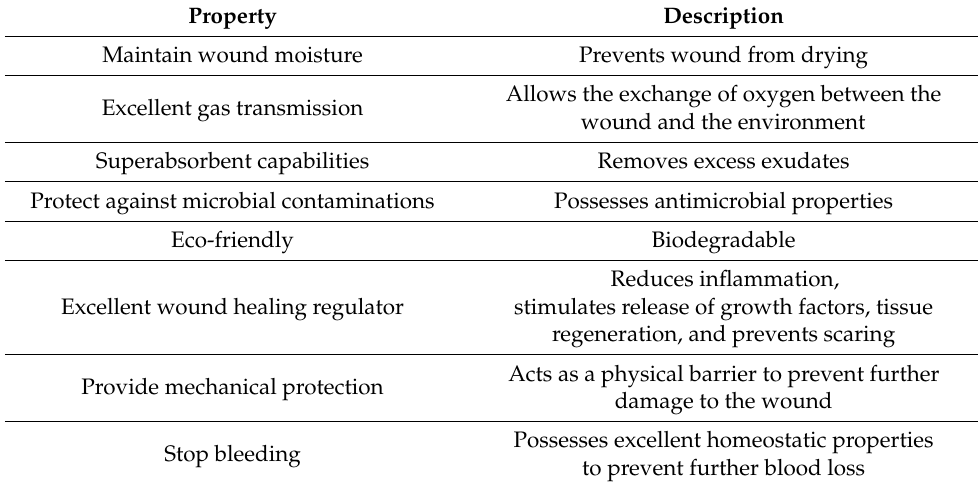
Table 2. Summary of the properties of ideal wound